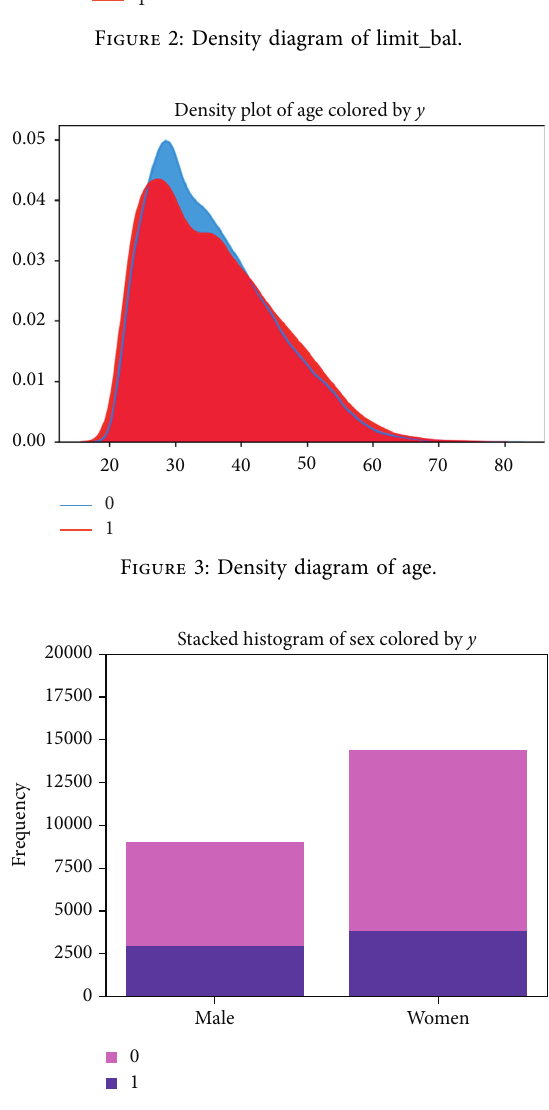
Figure 4: Stacked histogram of gender.